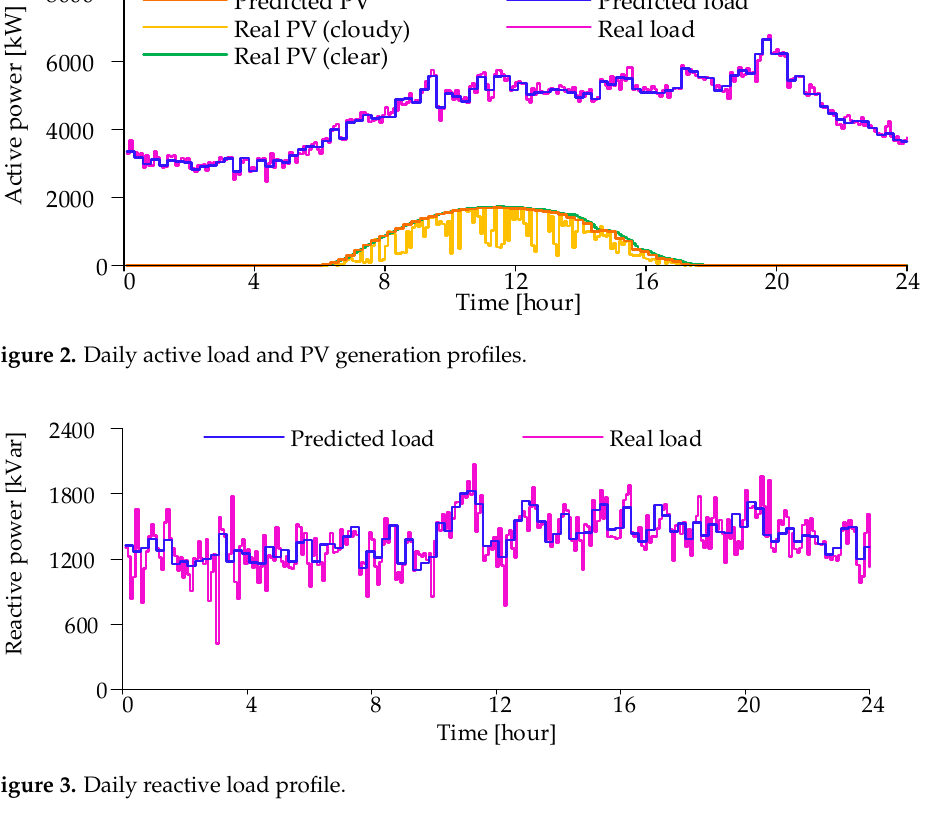
Feeder4 Figure 1. A modified 33-bus test system with multiple devices. Five ESSs are installed at buses 6, 15, 21, 24, and 30, with a 200 kW/1000 kWh capacity for each ESS. The maximum and minimum state of charge of the ESSs are 90% and 10%, respectively. The charging and discharging efficiency of the ESSs is 0.95. The initial state of charge is 40%. Three PVs are connected to buses 5, 19, and 24. The capacities of the PVs and their power converters are 600 kW and 600 kVA. This system has 3 OLTCs, and their locations are shown in Figure 1. The voltage control range of the OLTCs is between 0.95